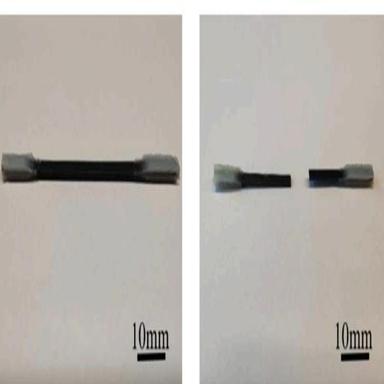
Reinforcement treatment at both ends and fracture condition of underfill.